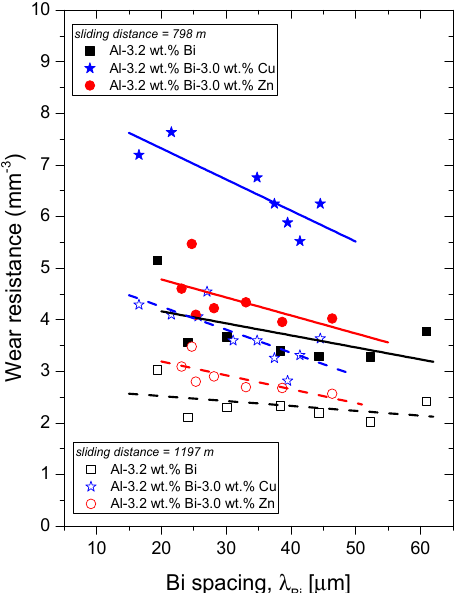
Figure 8. Wear resistance translated by the inverse of the worn out volume ( V ) as a function of the Bi spacing for either 798 or 1197 m of sliding distance related to the Al-Bi(-Cu,-Zn) alloys.